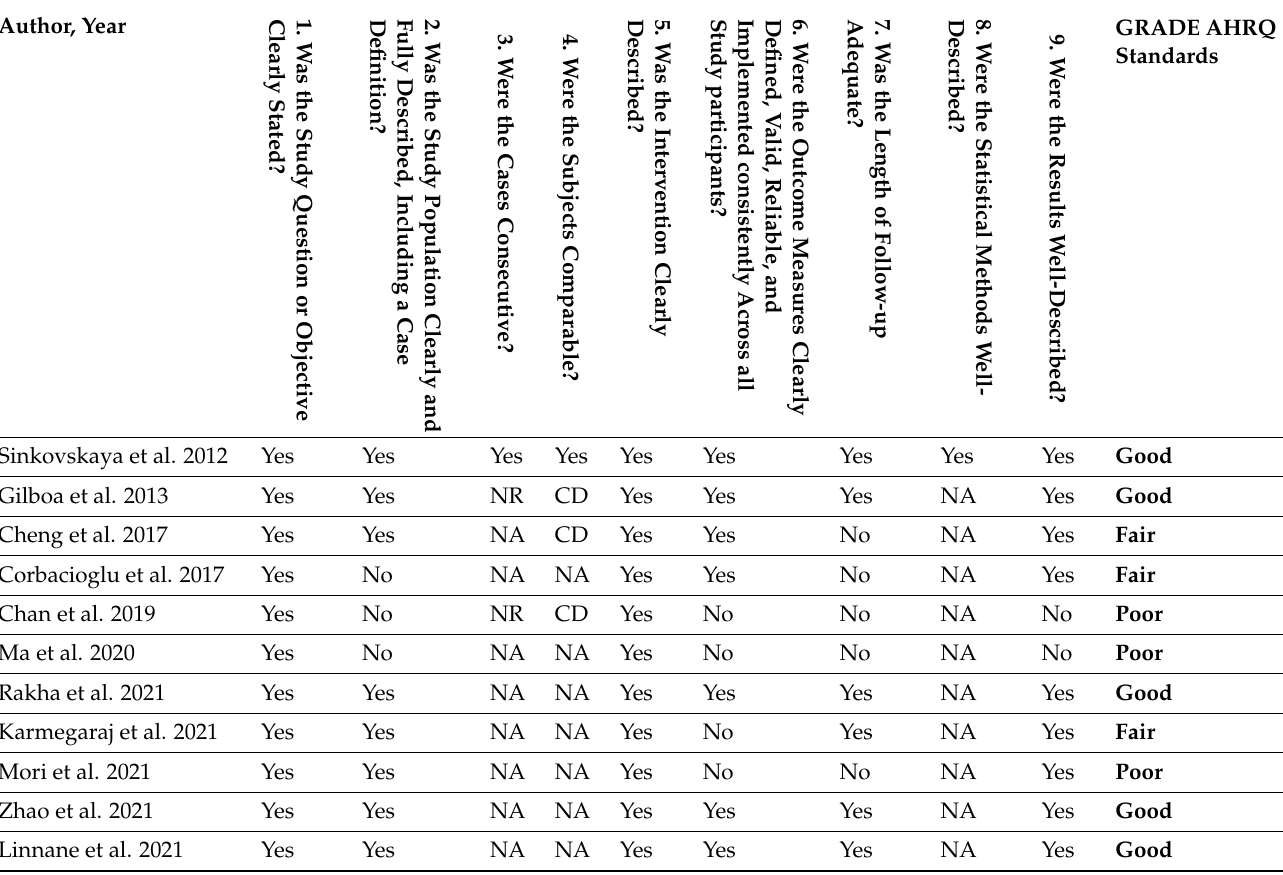
Table 1. Quality assessment of case series studies.